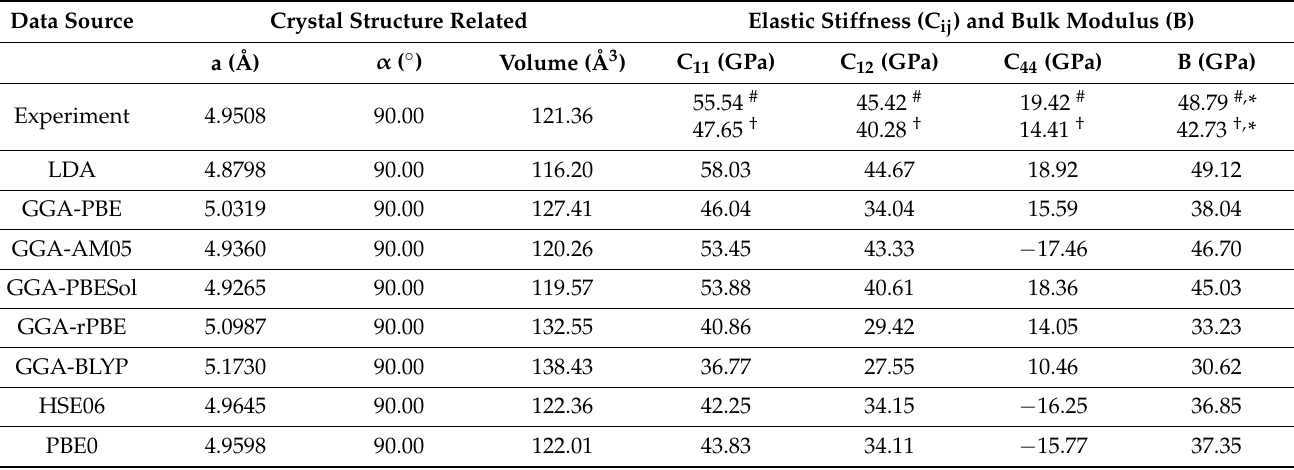
Table 2. Lattice parameter and mechanical properties estimated for pure Pb using various density functionals and hybrid